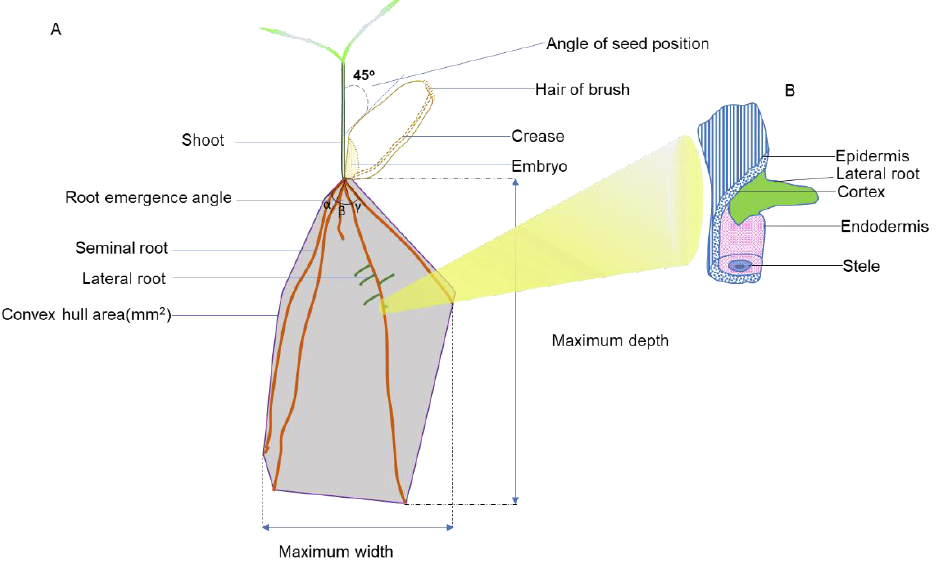
Figure 2. ( A ) Summary of seedling features within the growth system and the positioning of the seed. The positioning of the seed at 45 ◦ to the vertical plane of the growth system permitted the precise upward development of the coleoptile and concomitant downward growth of the roots. The crease of the seed is inverted to face the horizontal plane of the pouch, allowing the roots to grow away from the germination paper. ( B ) Illustration of lateral root emerging from the overlying tissues of the primary seminal root.